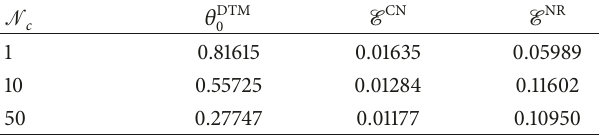
Table 6: Numerical solutions obtained for DTM and the maxi- mum error computed between the respective numerical solutions obtained, where E CN = max | CN sol − DTM sol | and E NR = max | CN NR sol − DTM sol | , and their respective temperatures at the tip of the fin for varied values of N 𝑐 . N 𝜃 DTM 𝑐 0 𝑟 .